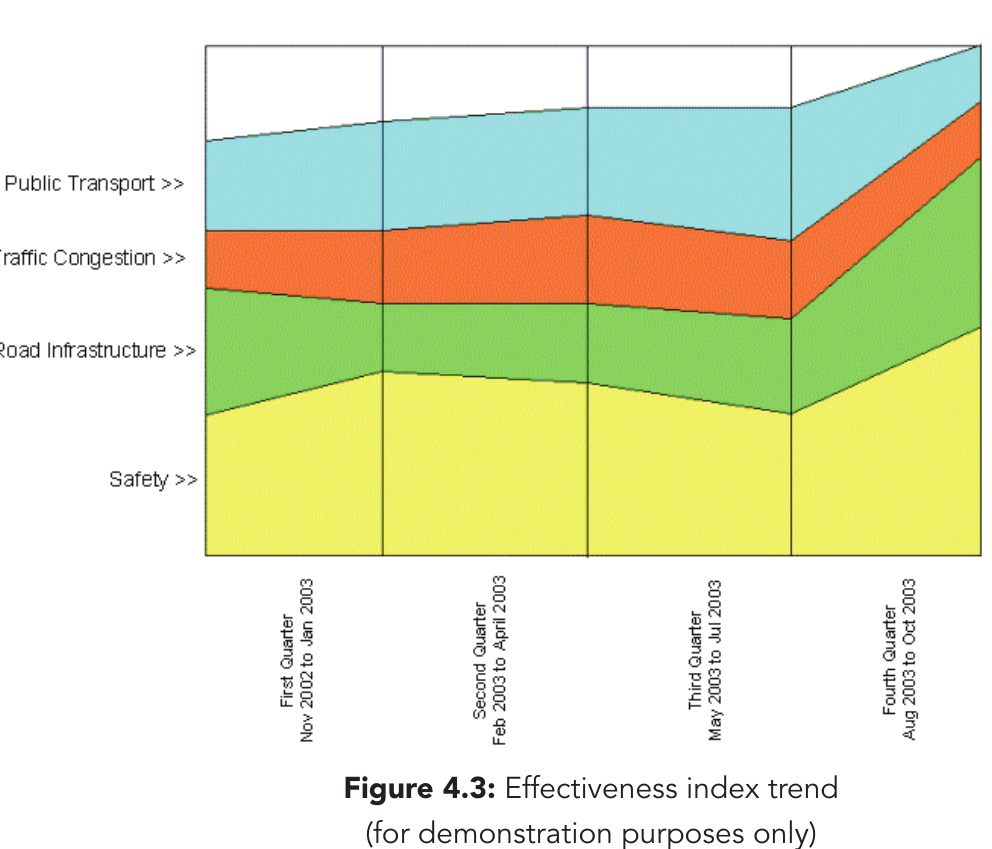
Figure 4.2: Effectiveness index (for demonstration purposes only)